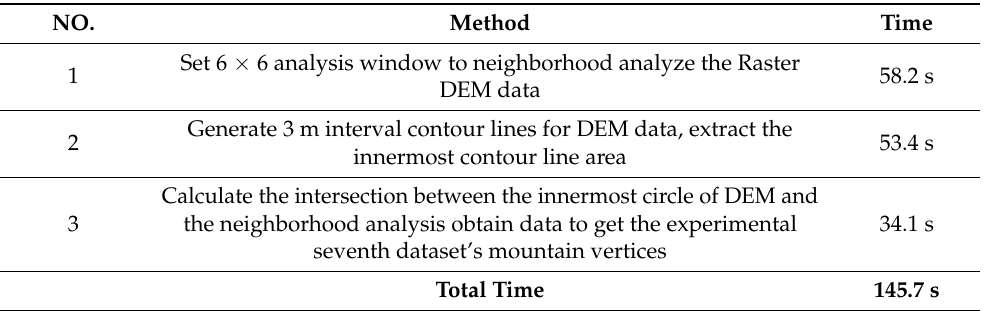
Table 24. The time spent in extracting mountain vertices for the seventh dataset using the Contour Line and Neighborhood Analysis Overlay